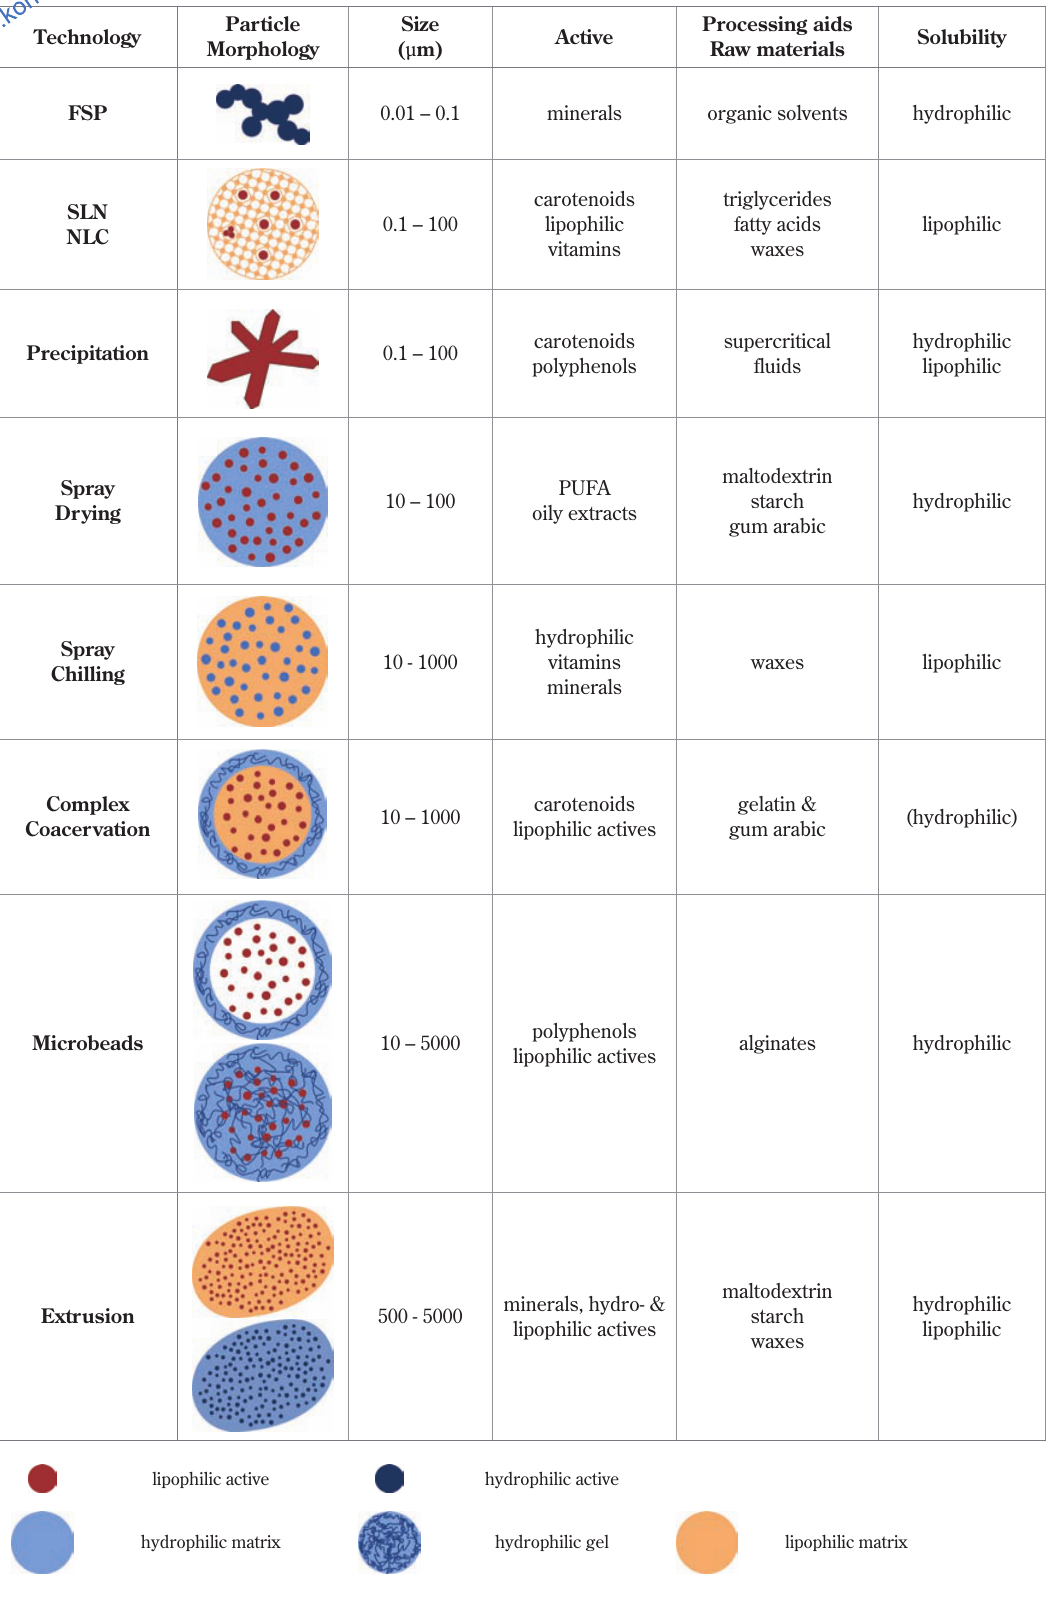
Table 3 Common synthesis and formulation technologies for nutraceuticals